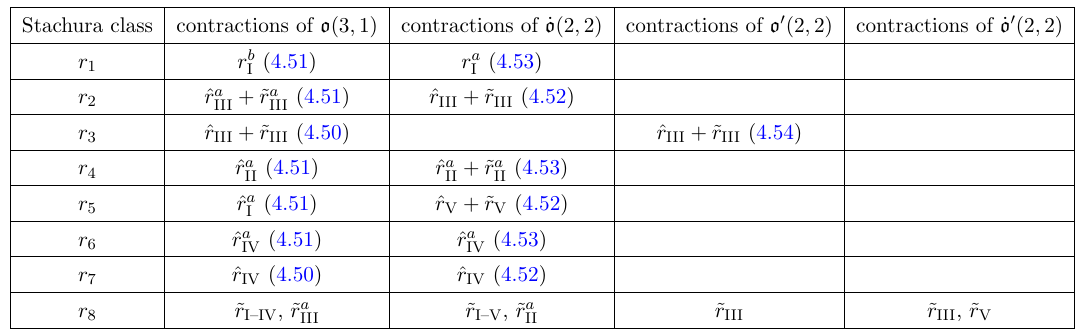
Table 3 . Comparison of our results from subsection 4.3{4.4 with the classi(cid:12)cation